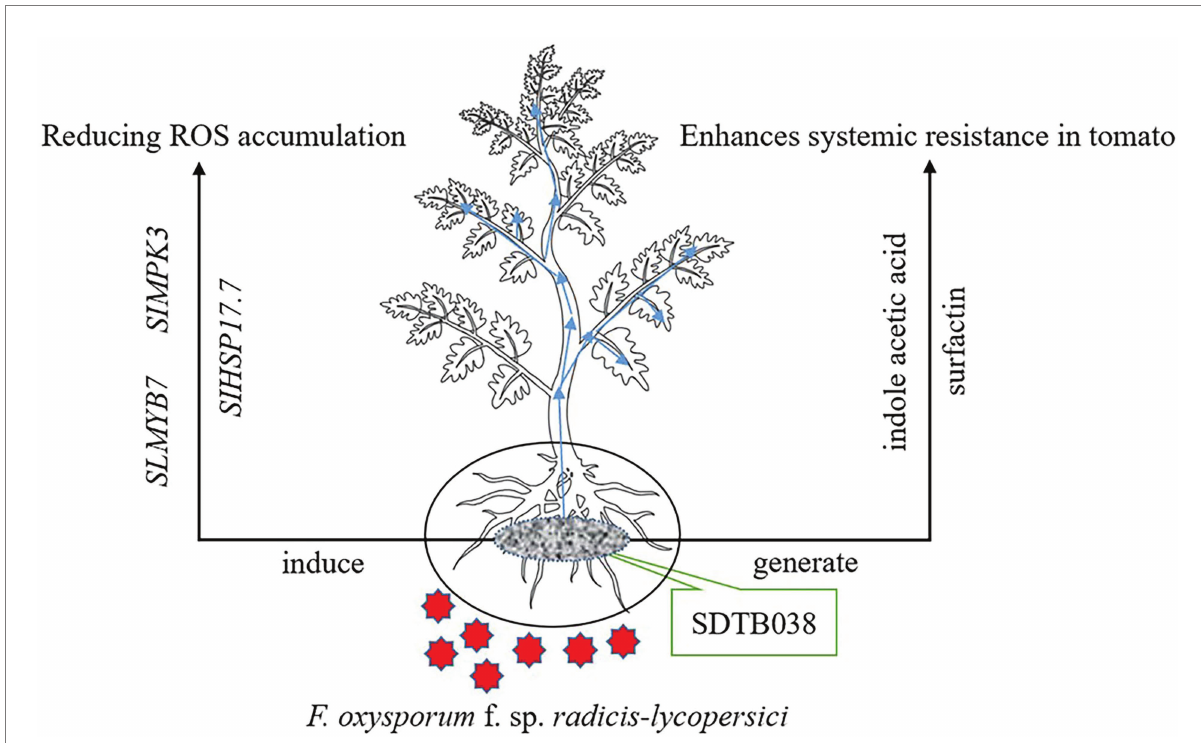
FIGURE 7 SDTB038 action mechanism diagram. Strain SDTB038 colonizes in tomato roots and can be moved to the rhizomes and leaves, which can induce the expression of antifreeze genes, produce indoleacetic acid and surfactin, and prevent and treat